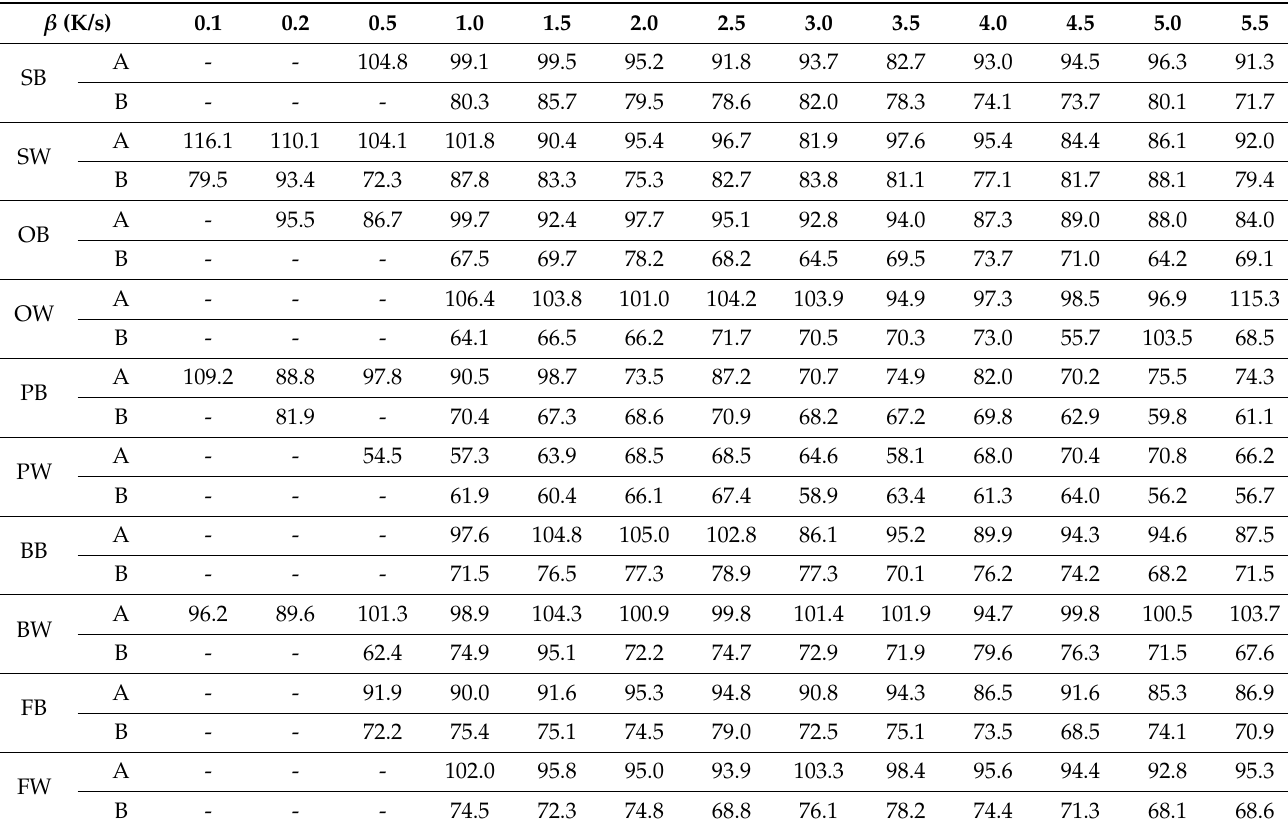
Table 6. Heat release capacity calculation results for ten wood samples with Method A and Method